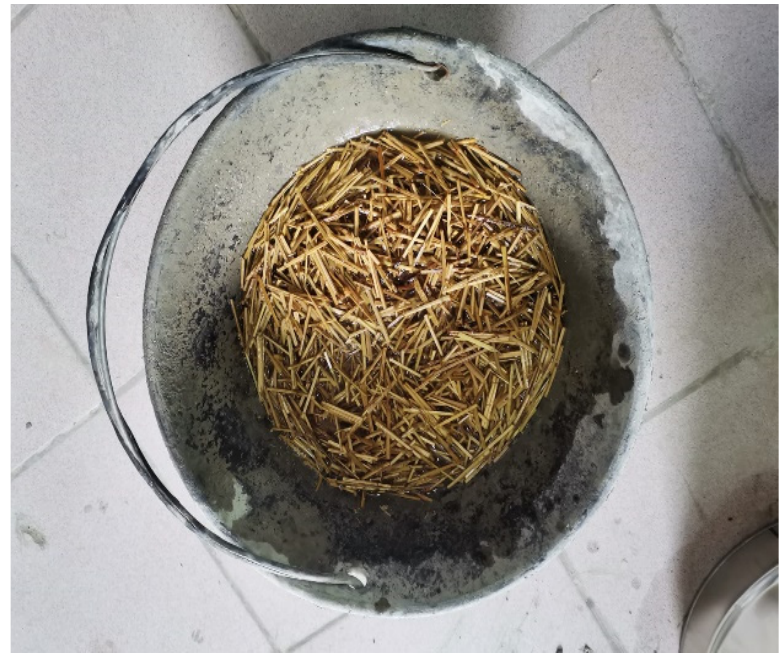
Figure 1. Waste glass: ( a ) pieces of glass; ( b ) fi ne aggregate/particles of glass (75 µm).